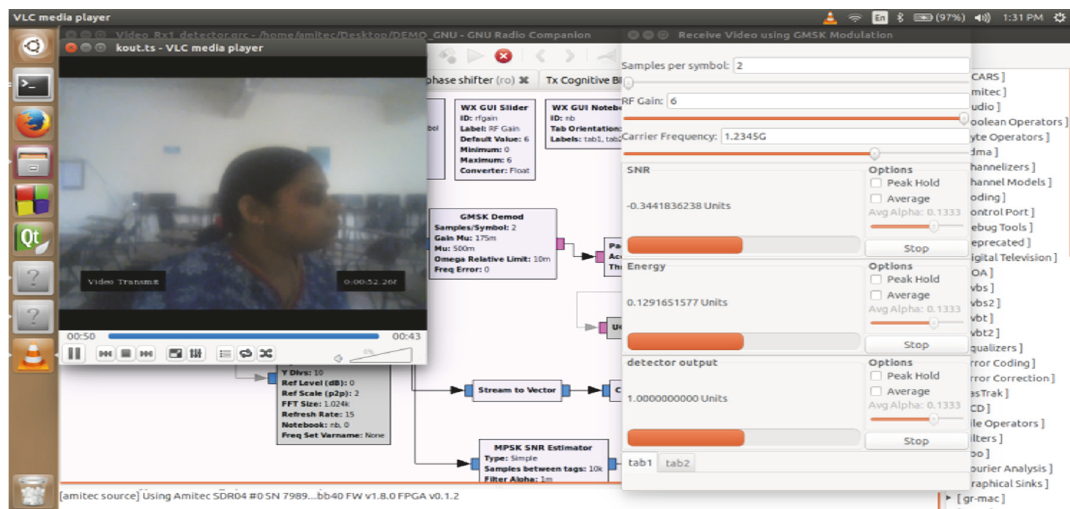
Figure 9: Energy based detector output is one as the transmission starts.